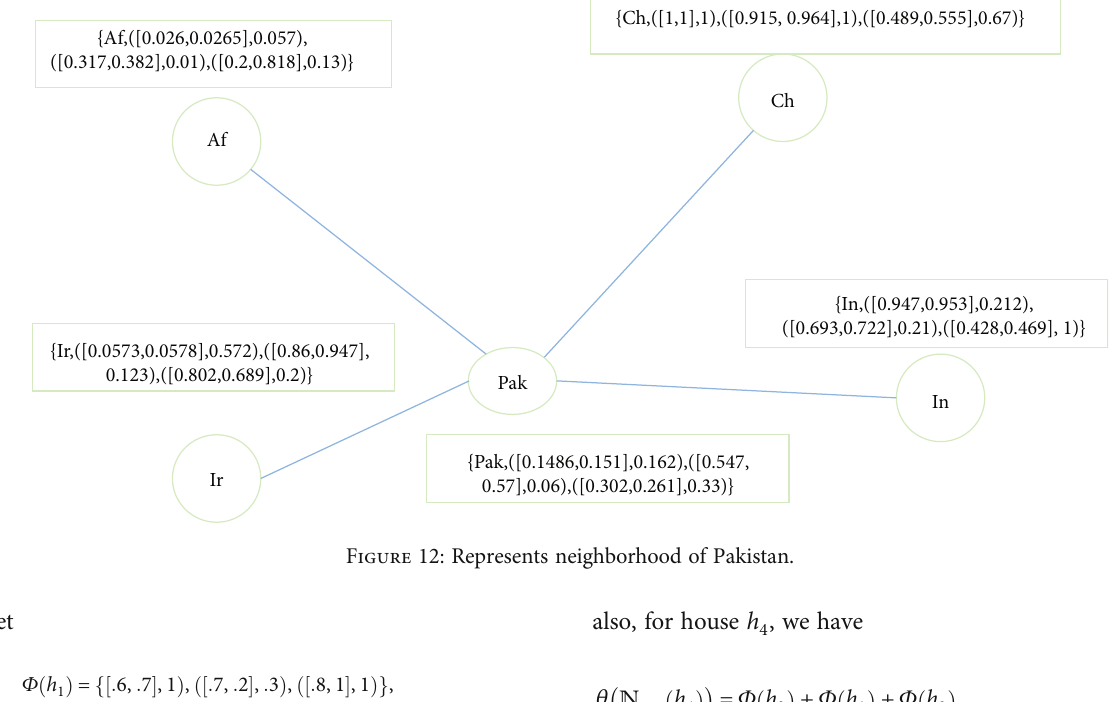
Figure 12: Represents neighborhood of